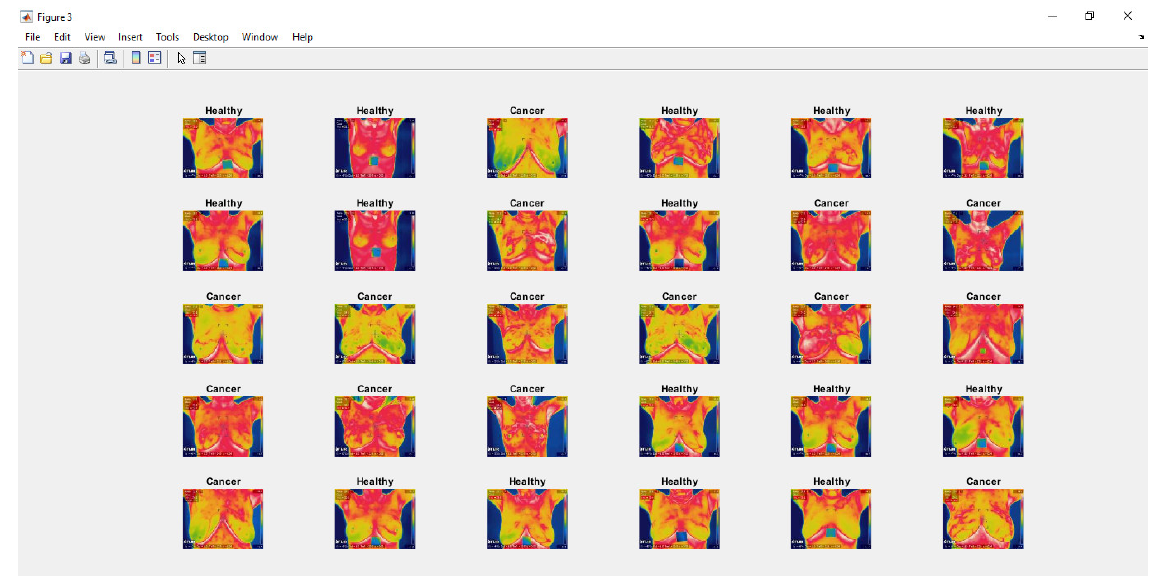
Figure 3. Thermal Images validated after training a deep convolutional neural network inception MV4. Table 1. Benchmarking Inception V3, V4, and MV4 on the